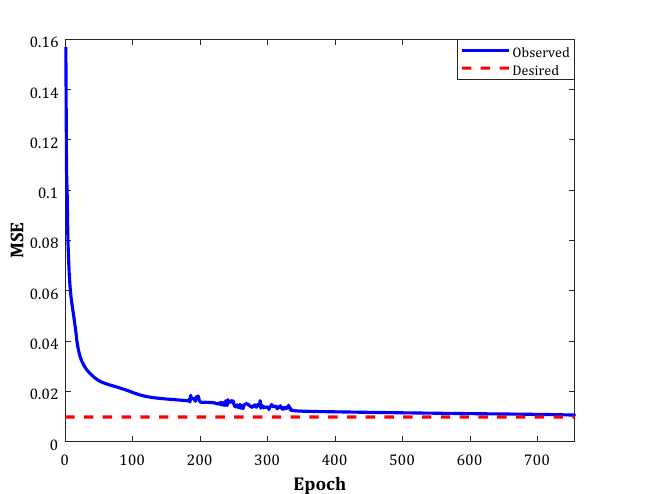
Figure 5. Rank order of different WT-ANN topologies differing from their number of hidden nodes and B-spline wavelet shape.